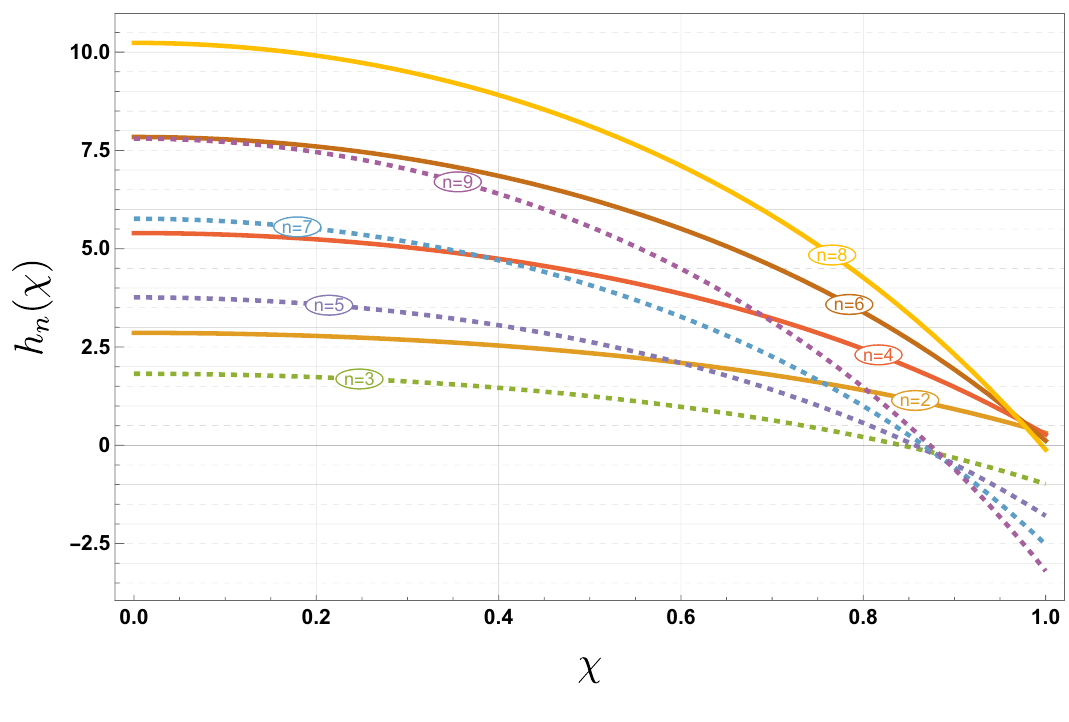
Figure 4 . The relative corrections to the multipole moments h n , defined in (4.17). Observe that the functions h n follow a different pattern for odd and even n